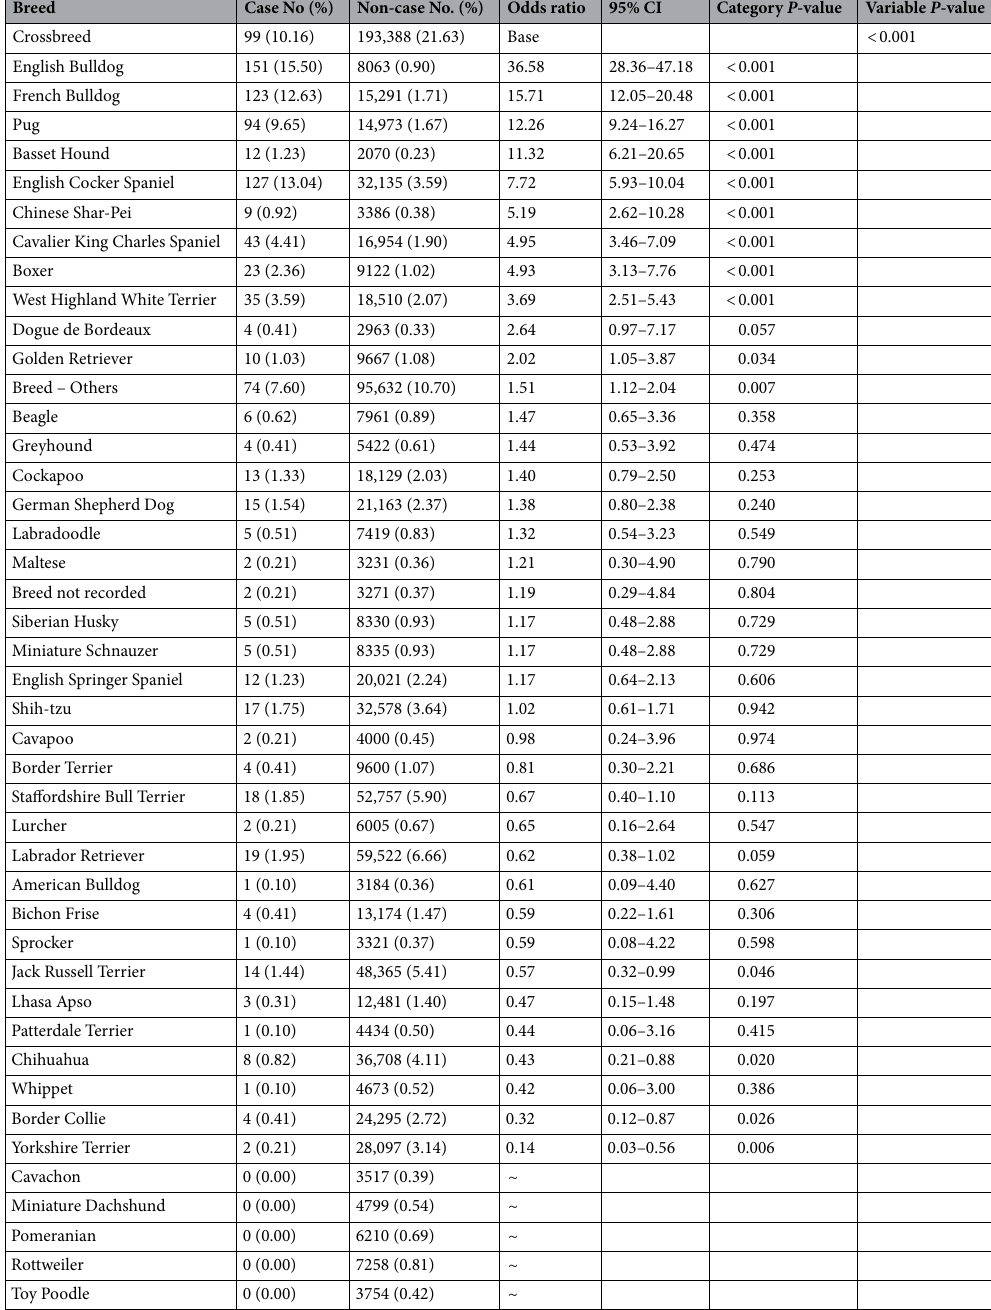
Table 1. Descriptive and univariable logistic regression results for breed as a risk factor for skin fold dermatitis during 2016 in dogs under primary veterinary care in the VetCompass Programme in the UK. Column percentages shown in brackets. CI confidence